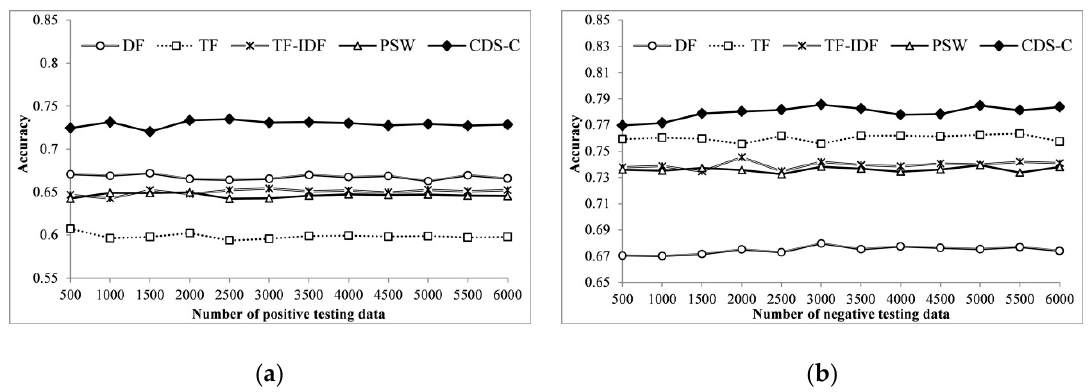
Figure 5. The comparisons of accuracy with the tested documents of different polarity. ( a ) Positive; ( b ) Negative.